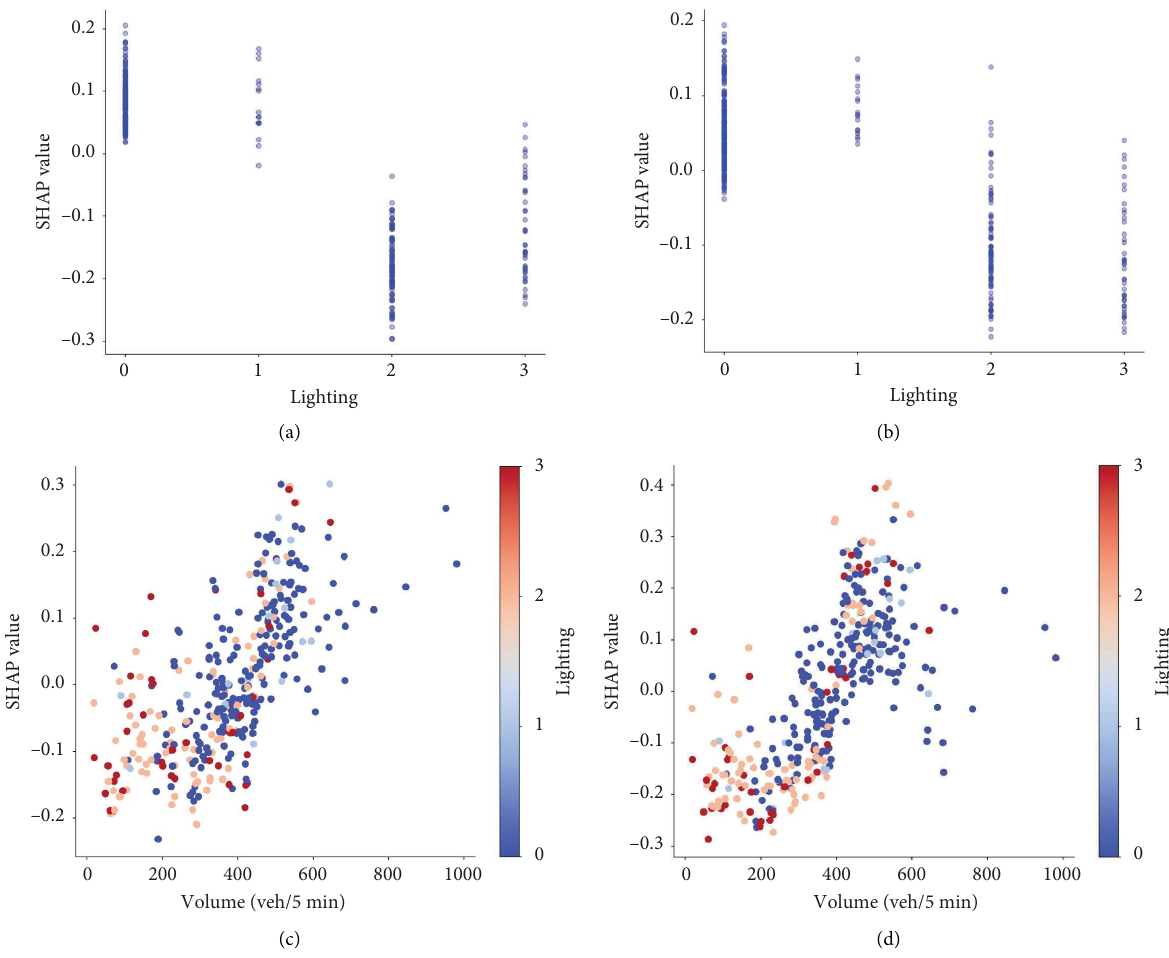
Figure 7: SHAP local dependence plots of lighting. (a) Main efects of lighting on the time gap. (b) Main efects of lighting on the distance gap. (c) Interaction efects between volume and lighting on the time gap. (d) Interaction efects between volume and lighting on the distance